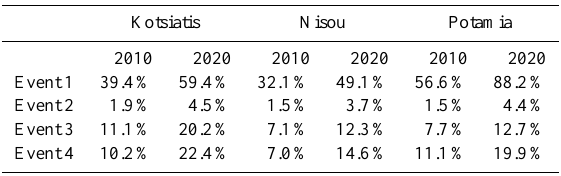
Table 5. Changes in Yialias simulated peak discharge due to land cover change in 2010 and 2020 compared to the 2000 land